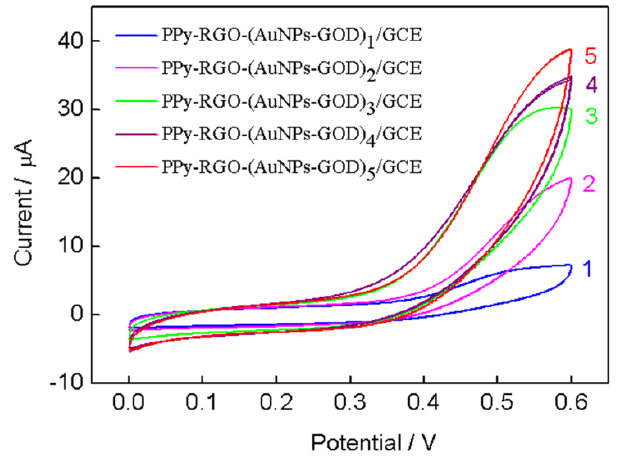
Figure 5. CVs of different layers of AuNPs-GOD multilayer films modified PPy-RGO/GCE in 10 mM glucose. The layer number of multilayer films was indicated on the graph. Scan rate, 50 mV/S.